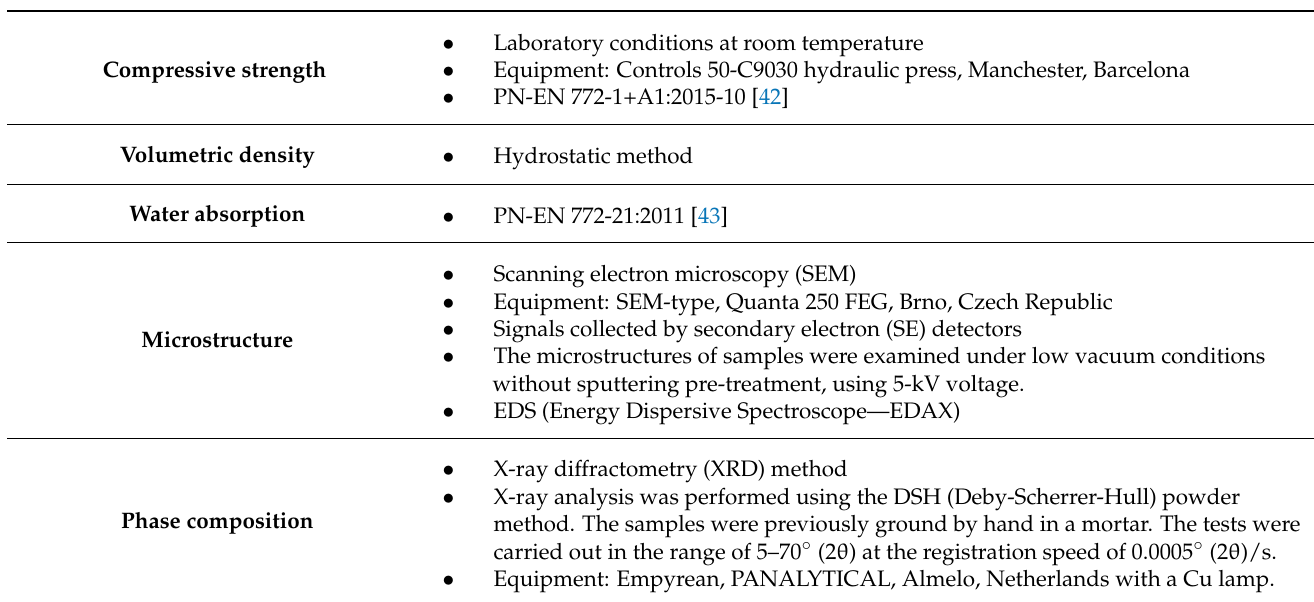
Figure 4. Broken silica–lime sample with GG after compressive strength test. Table 6. The methodology of conducted